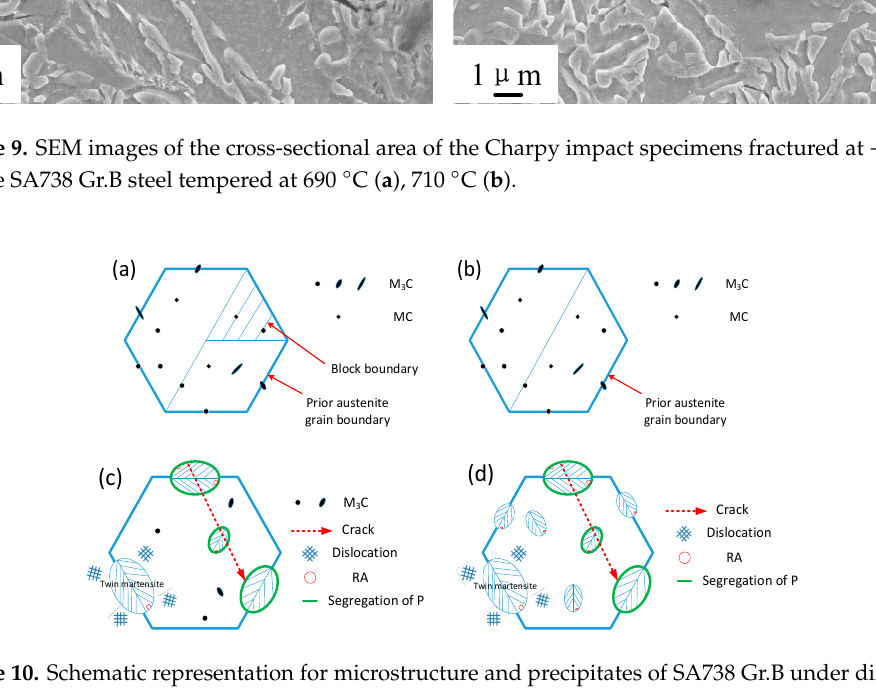
Figure 9. SEM images of the cross-sectional area of the Charpy impact specimens fractured at − 45 °C for the SA738 Gr.B steel tempered at 690 °C ( a ), 710 °C ( b ).